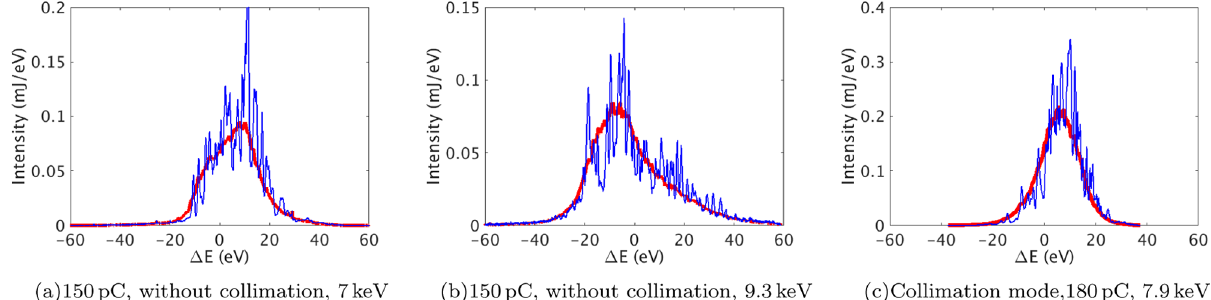
FIG. 9. The measured hard x-ray SASE FEL spectra for operating mode without collimation (a) and (b), and with collimation (c). The blue curve is a single-shot example, and the thick red curve is averaged with 100 shots. In (a), measured on 5/23/15, the bunch charge is 150 pC from injector to the undulator, photon energy is 7 keV, bandwidth is ∼ 25 eV FWHM, and pulse energy is about 2.7 mJ; in (b), measured on 4/29/15, the bunch charge is 150 pC from injector to the undulator, photon energy is 9.3 keV, bandwidth is ∼ 25 eV FWHM, and the pulse energy is 2.6 mJ; in (c), measured on 6/23/16, the charge is truncated with BC1 collimator from 250 pC to 180 pC, photon energy is 7.9 keV, bandwidth is ∼ 15 eV, and the pulse energy is 4.3